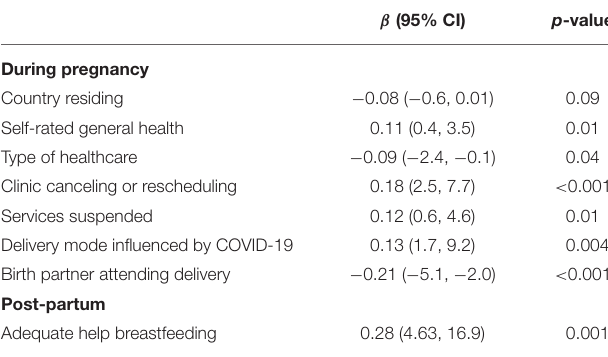
TABLE 6 | Multiple Regression Predicting Quality of Care for pregnant and postpartum